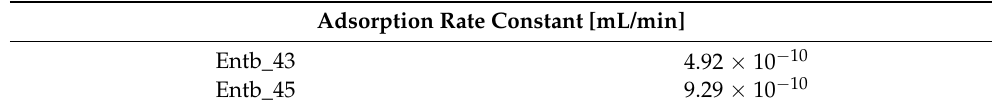
Table 6. Adsorption rate constant for phage Entb_43 and phage Entb_45.